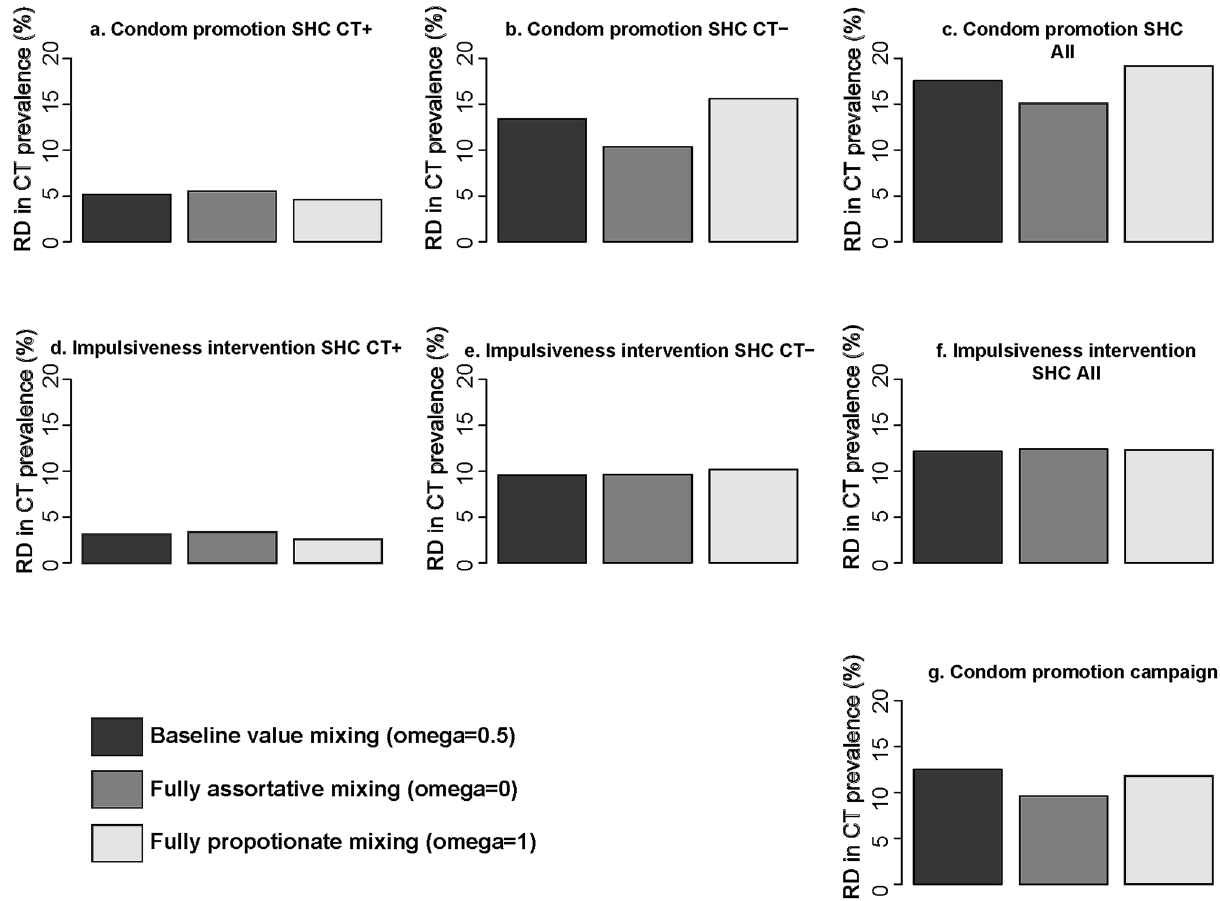
Figure 3. Uncertainty analyses mixing parameter. Impact on overall chlamydia prevalence five years after the introduction of condom promotion at SHC (a–c) , impulsiveness intervention at SHC (d–f) , targeted at only at individuals who tested chlamydia positive (CT +), only at individuals who tested chlamydia negative (CT−), and targeted at all tested (All), and the condom promotion campaign (g) , for different values of the mixing parameter. CT Chlamydia trachomatis , CT + Chlamydia trachomatis positive; CT − Chlamydia trachomatis negative, RD relative